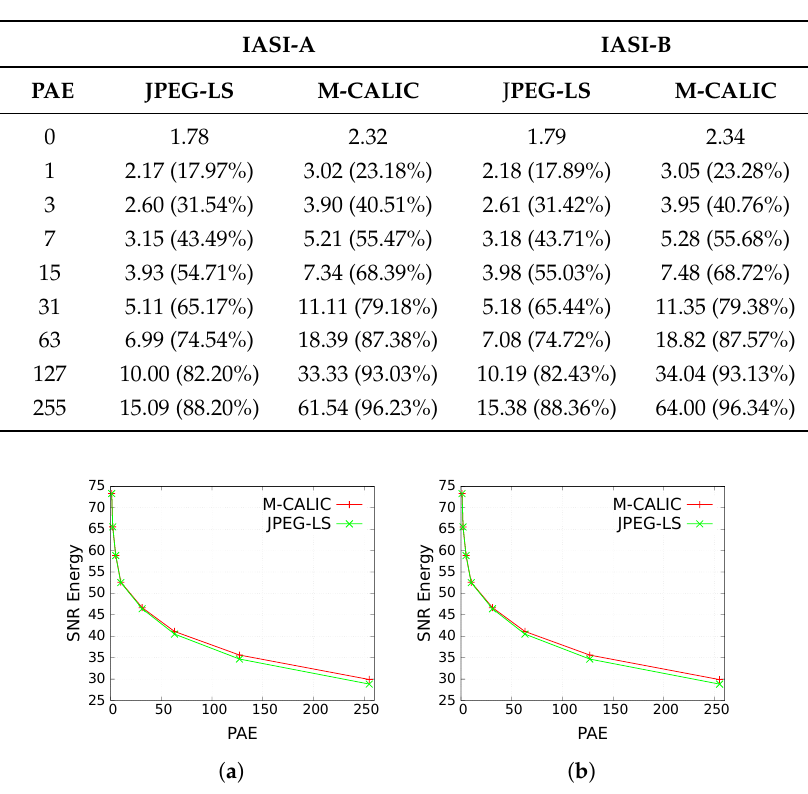
Table 9. Near-lossless compression of IASI L1C products. Results are reported in compression ratio (higher is better). Results for lossless compression (PAE = 0) are included. Percent savings (higher is better) with respect to lossless compression are provided within brackets.